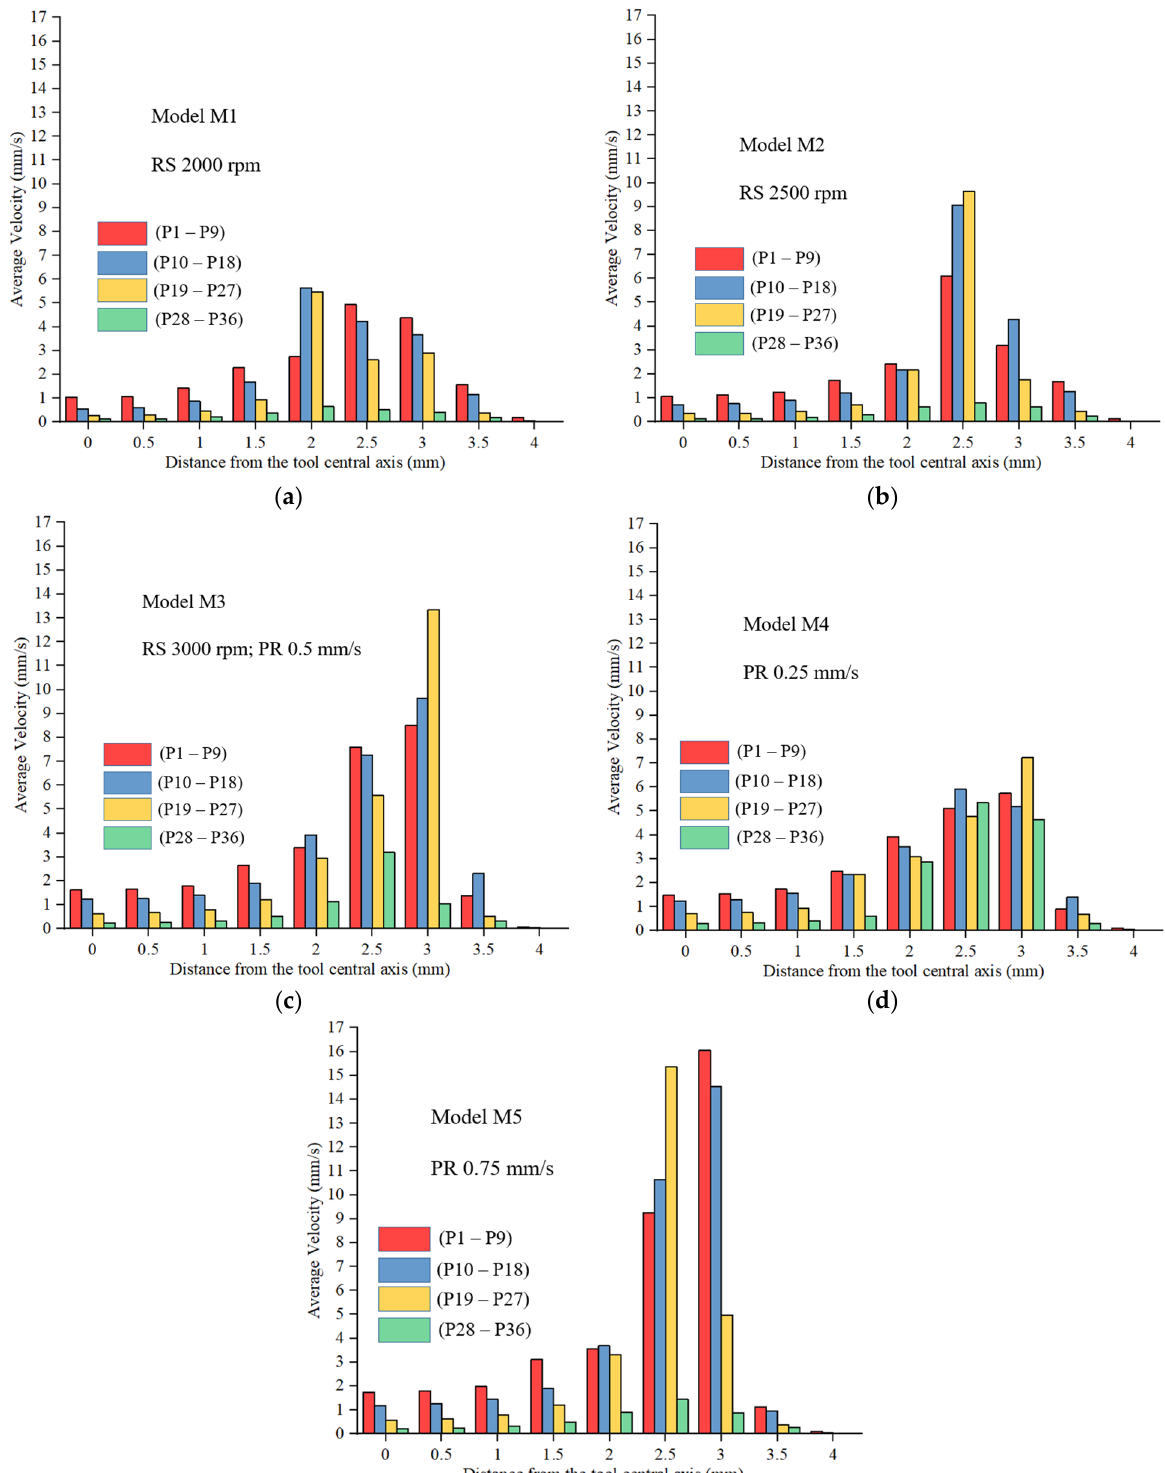
Figure 7. Time-averaged velocities from the characteristic points that are marked in Figure 6, ( a ) model M1; ( b ) model M2; ( c ) model M3; ( d ) model M4; ( e ) model M5. The lap shear strengths (LSS) reported from the experiments with the same parameters of models M1, M2, M3, M4, and M5 were 2752 N, 2917 N, 3069 N, 2918 N, and 2957 N, respectively [31]. According to the results of the experimental LSS tests, RS had a